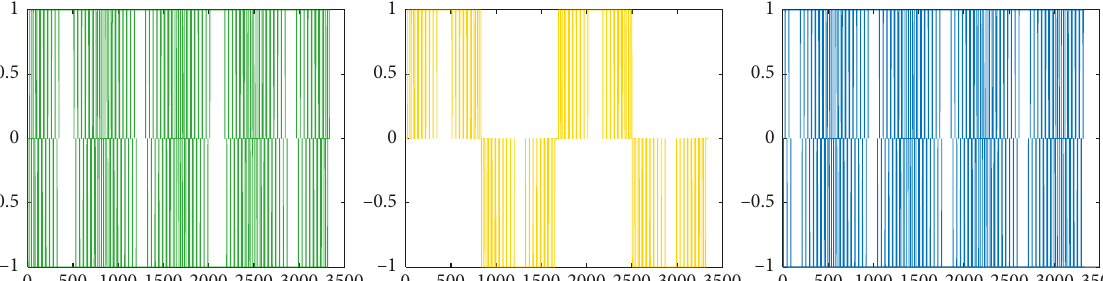
Figure 4: The number of lines of code of a course.